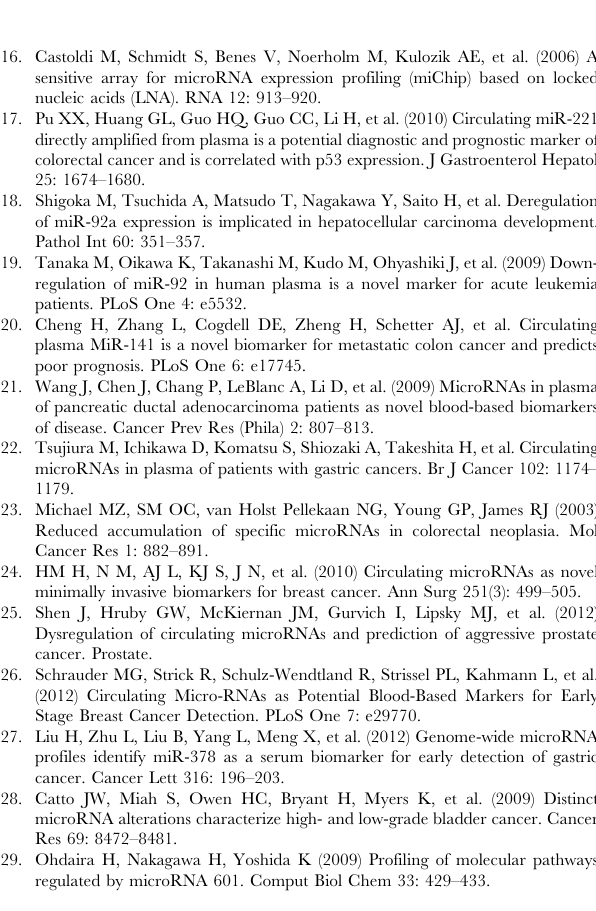
Figure S5 ROC curve analysis of plasma miR-601 and